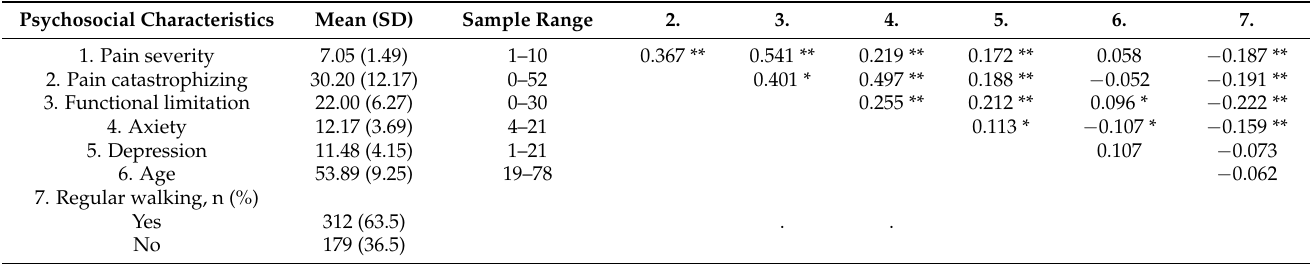
Table 1. Descriptives and correlations between variables (n = 491).